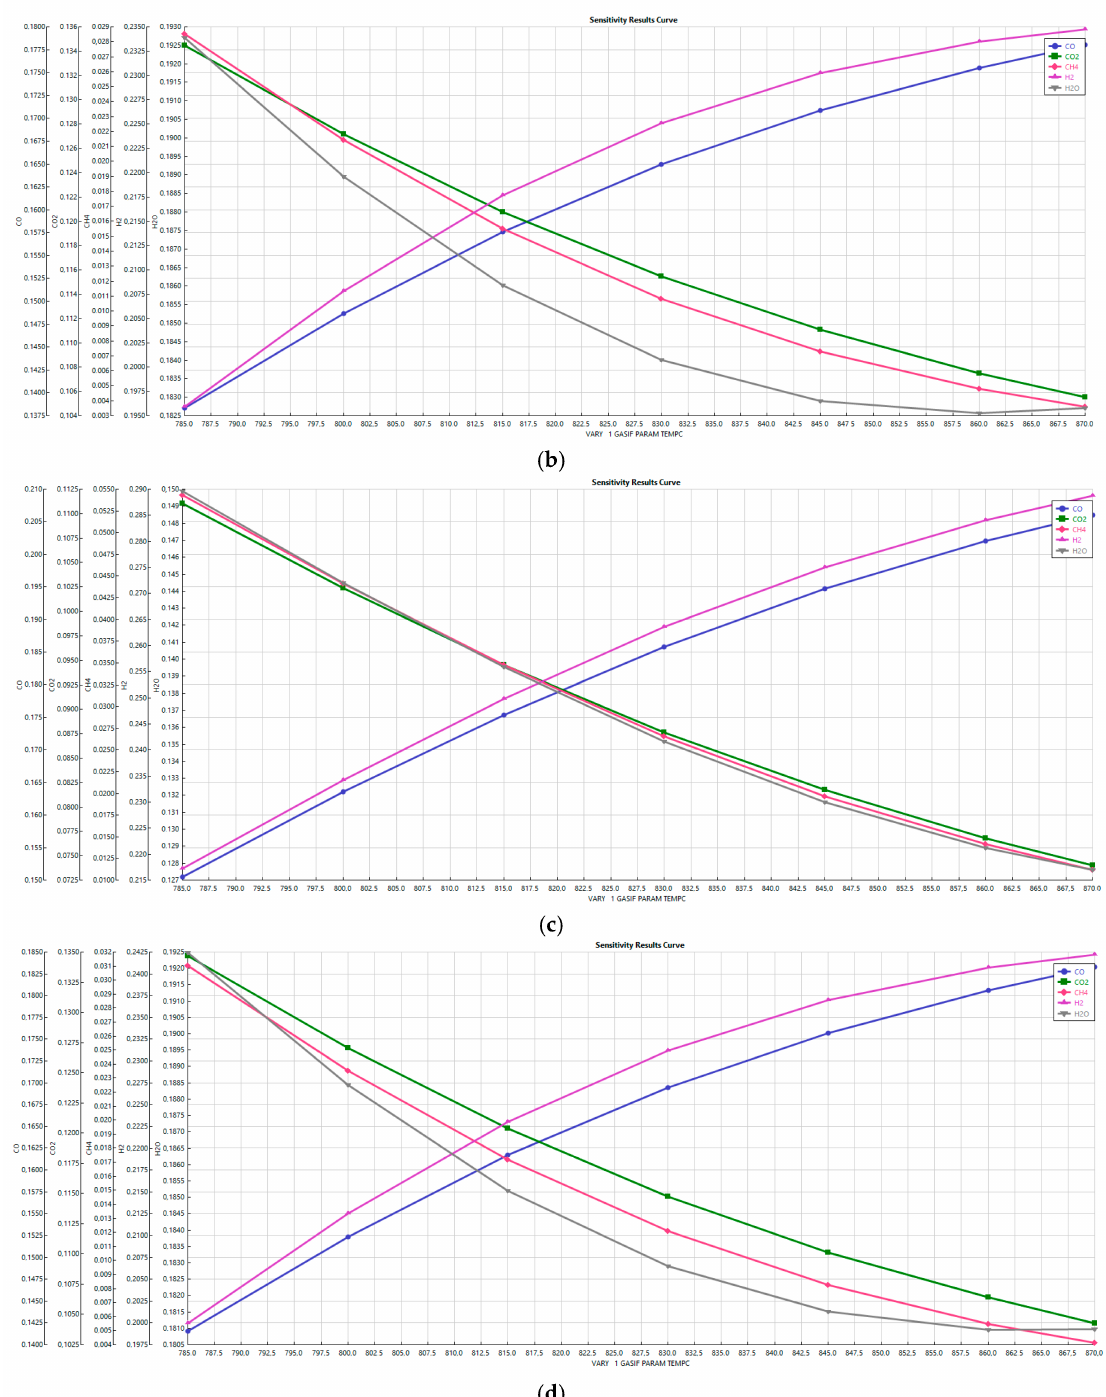
Figure 4. ( a ) Effect of gasification temperature on the syngas composition from hazelnut shells. ( b ) Effect of gasification temperature on the syngas composition from olive pruning. ( c ) Effect of gasification temperature on the syngas composition from olive pomace. ( d ) Effect of gasification temperature on the syngas composition from wheat